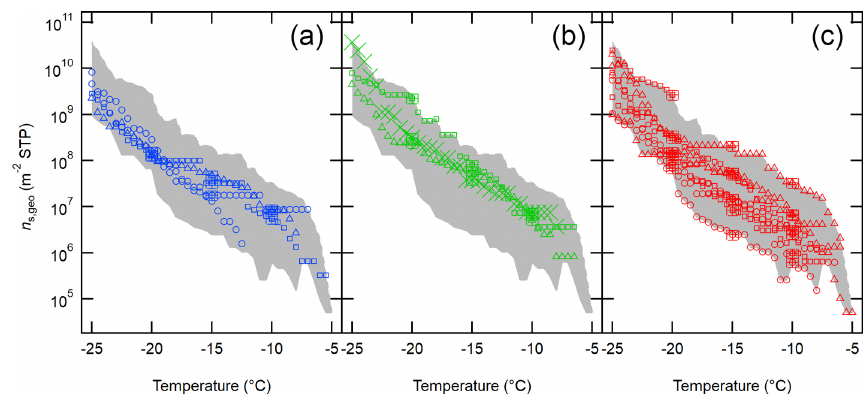
Figure 8. The n s , geo spectra of OLLF aerosol particles from field ambient samples collected in 2017–2019. All downwind n s , geo spectra from winter (a) , spring (b) , and summer (c) are shown. Different symbol shapes correspond to individual OLLF sites as indicated in the legend. The uncertainties in temperature and n s , geo are ± 0 . 5 ◦ C and ± 23 . 5%, respectively, and representative error bars are shown at − 5, − 10, and − 15 ◦ C. The shaded area represents minimum − maximum n s , geo . Table 7. Summary of the ambient conditions during field sampling activities: UW denotes